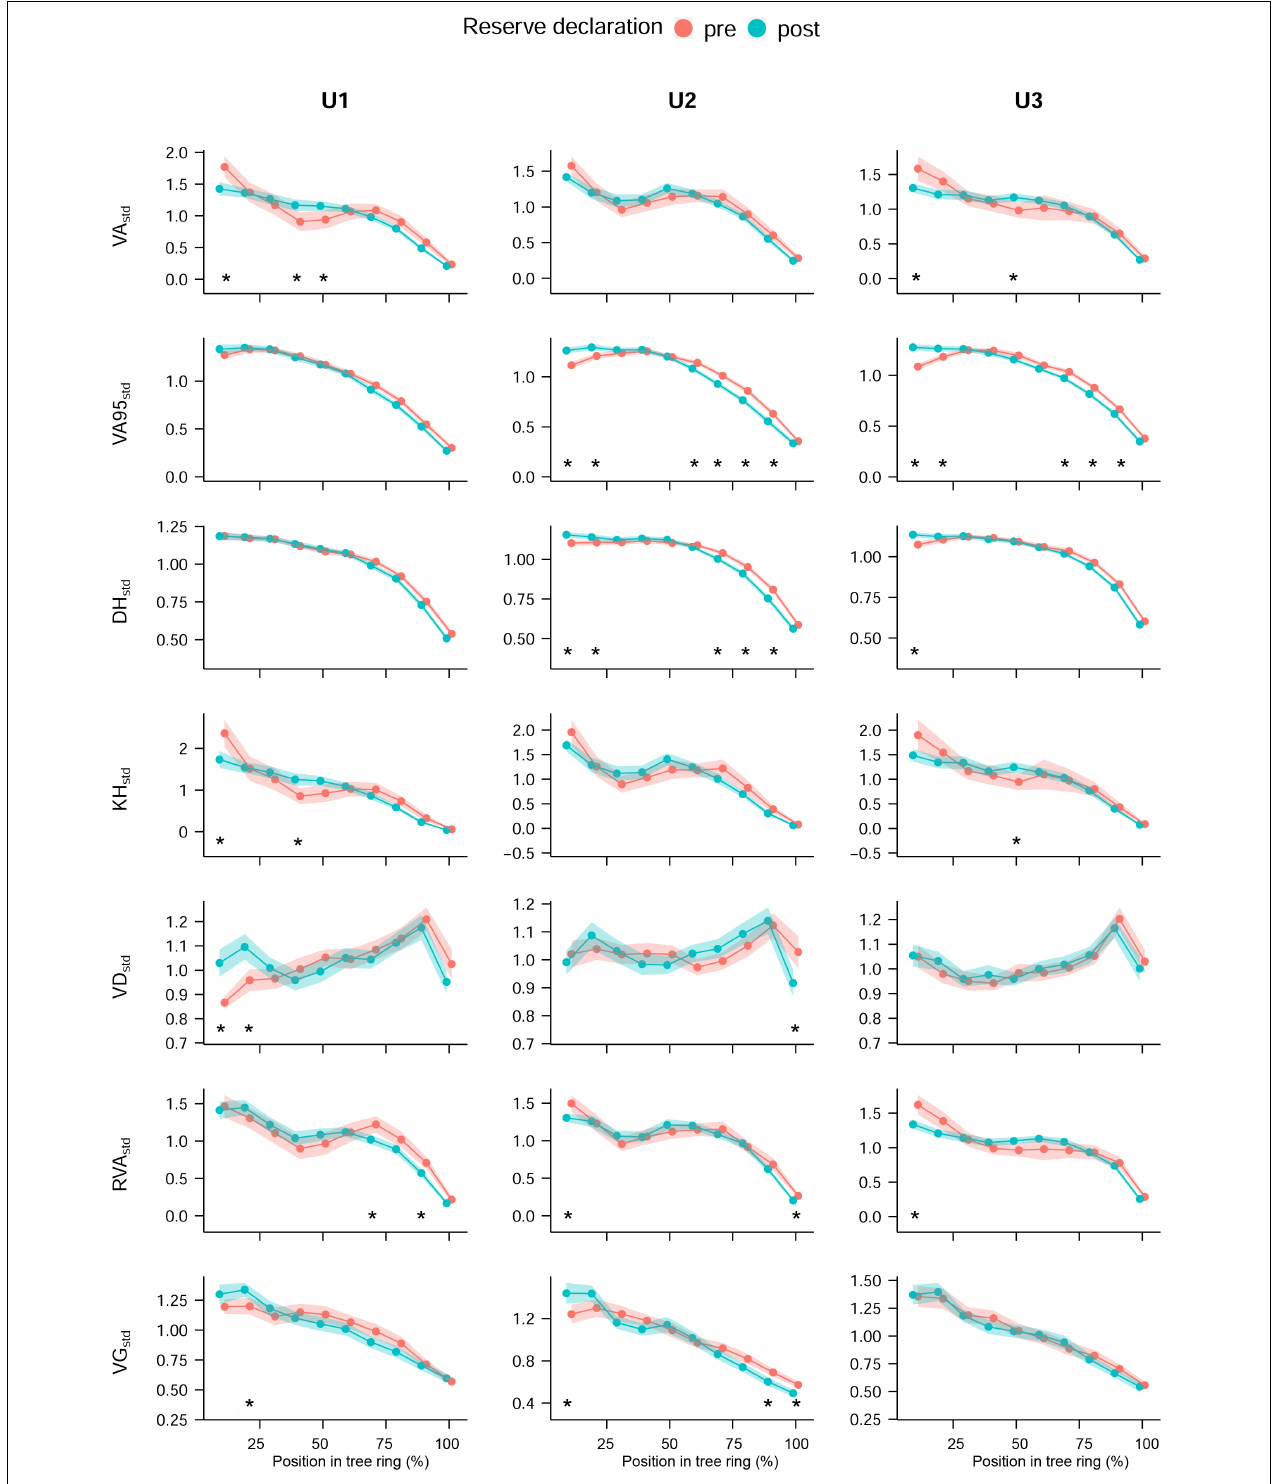
FIGURE 4 | Standardized intra-annual values of each land use period. Land use periods refer to the periods before (1968–1981) and after (1990–2004) the declaration of Ugni as Natural State Reserve in 1981 at the different study sites, which coincided with the cessation of coppicing: U1—1,200 m a.s.l.; U2—1,600